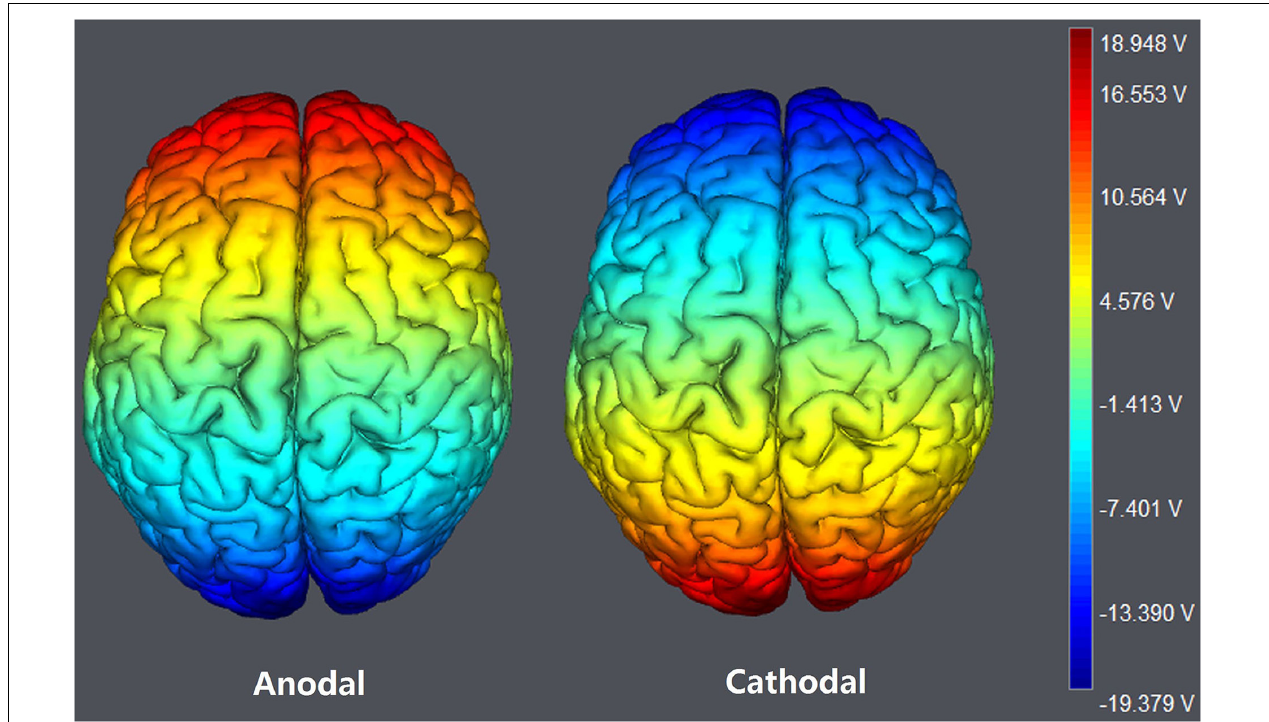
FIGURE 2 | The stimulation models of tDCS treatments. Electric field stimulations were performed with the Neuroelectrics Instrument Controller software (version 1.3, Spain). Stimulated field intensity is indicated by the color bar. The axis represents the range of input voltage from -19.379 to 18.948